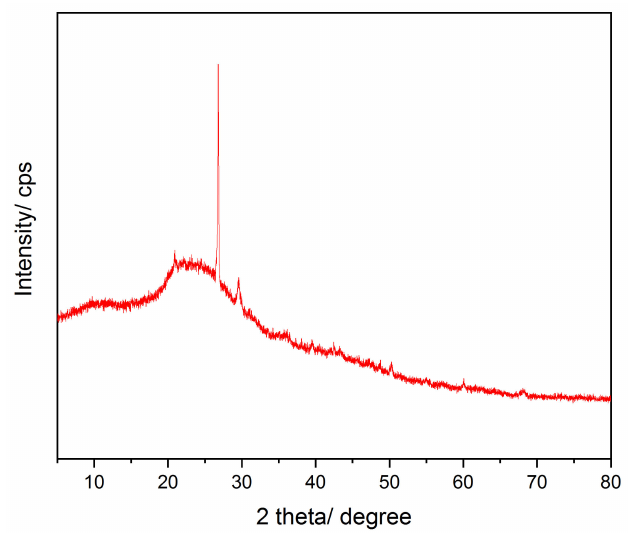
Figure 4. Powder XRD pattern of BCR.